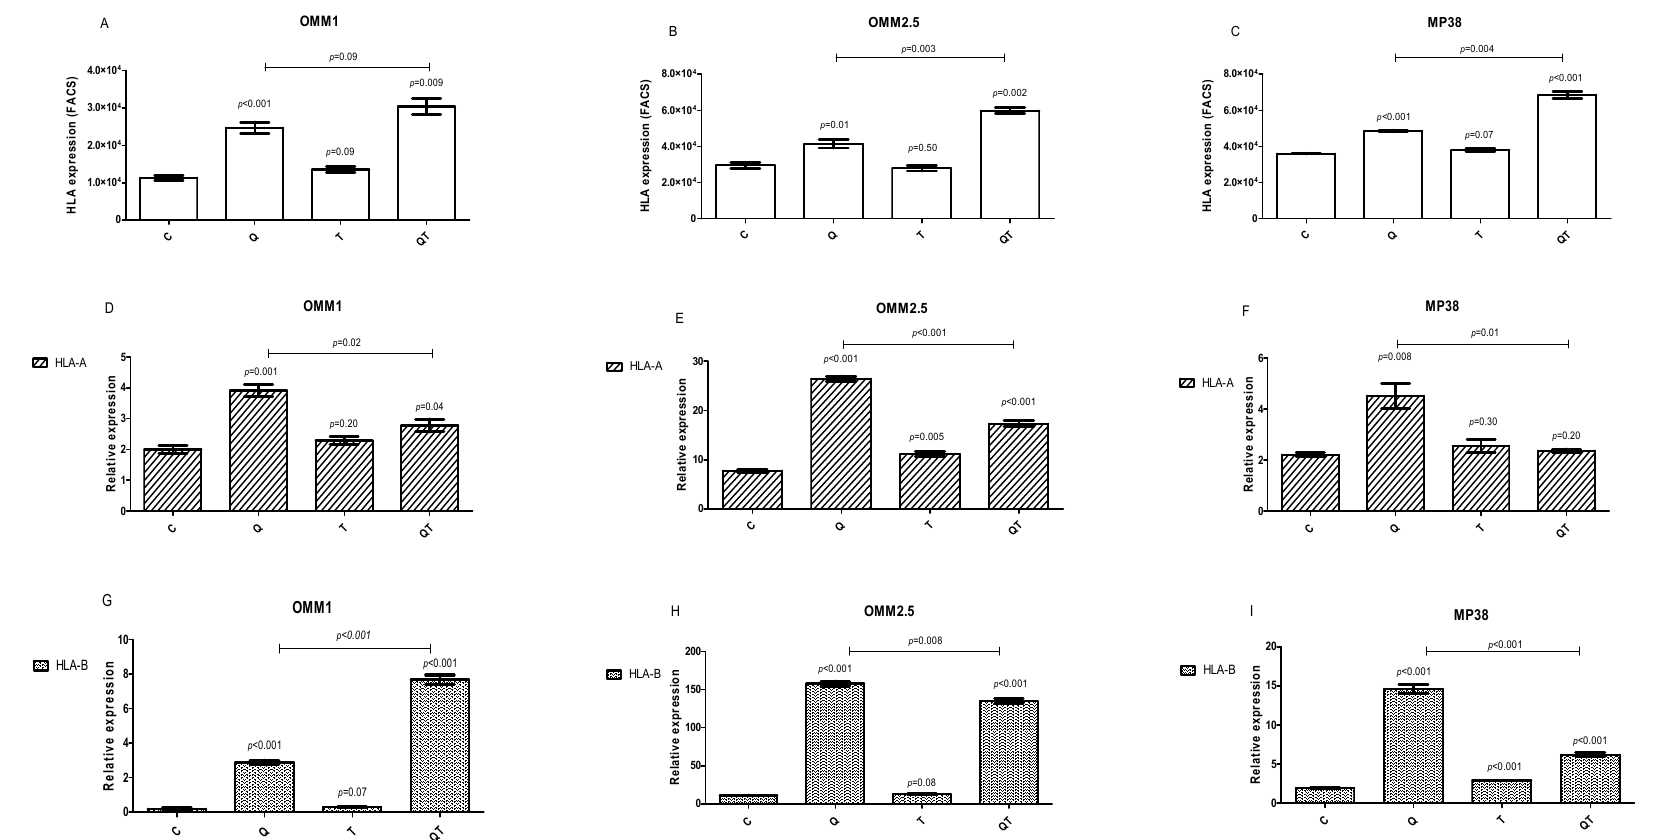
Figure 4. HLA Class I cell surface protein expression and mRNA levels after 48 h of treatment with Quisinostat and/or Tazemetostat compared to the control. Cell surface expression was determined by FACS using anti-HLA W6/32 antibody ( A – C ). HLA-A mRNA ( D – F ) and HLA-B mRNA ( G – I ) expression was determined by qPCR. C: control; Q: 40 nM Quisinostat; T: 5 µM Tazemetostat; QT: combination of 40 nM Quisinostat and 5 µM Tazemetostat. Using an Independent t-test, p ≤ 0.05 was considered significant. Error bars indicate the standard error of the mean of three measurements.